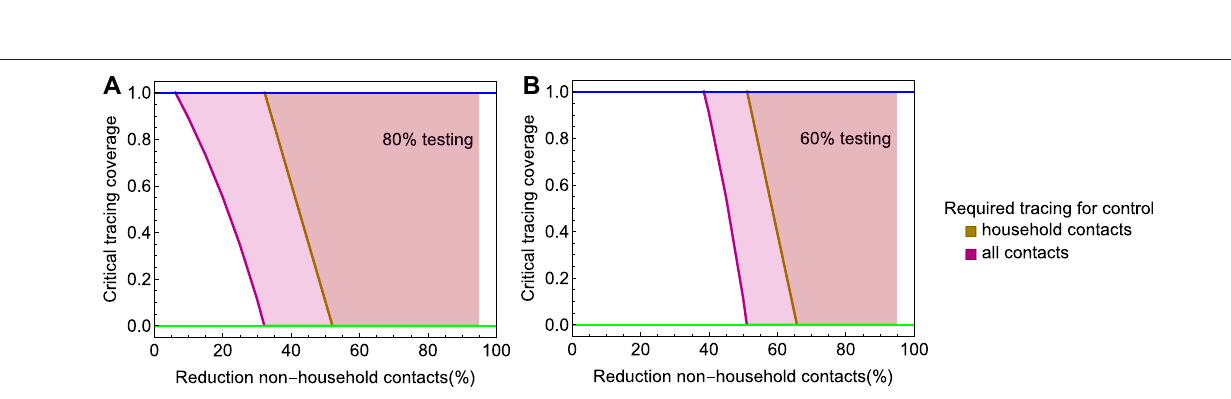
FIGURE7| Thecriticaltracingcoverageinapopulationwithsocialdistancingand R 0 (cid:2) 2 . 5 . Inthebrownshadedareatracingofhouseholdcontactsissuf fi cient,in the purple area a certain level of non-household contacts have to be traced in addition to 100% of household contacts. (A) 80% testing coverage; (B) 60% testing